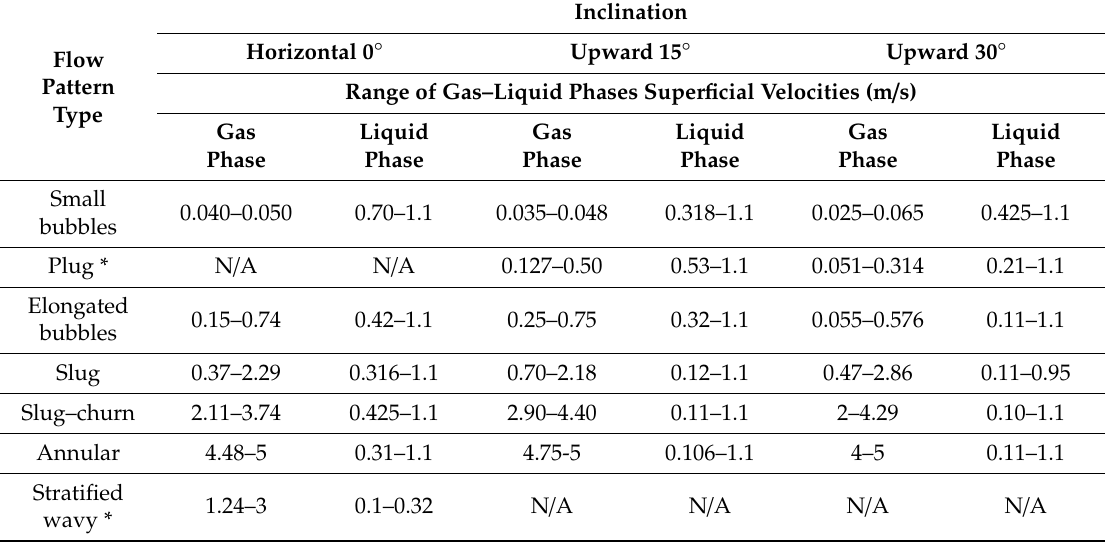
Table 3. A summary of the experimental maps for all inclinations as a function of the two phases superficial